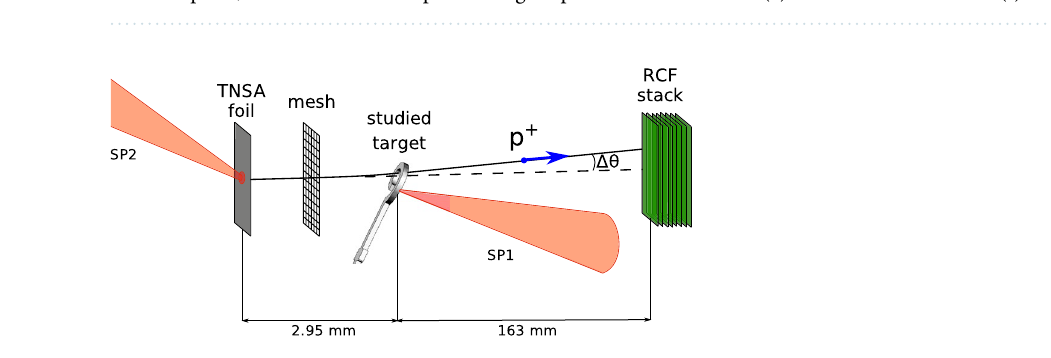
Figure 1. The target sketch ( a ) and the magnified photographic image ( b ). Scheme of the setup used in Shot #18 ( c ) and #22 ( d ). Proton radiography image obtained in Shot #18 in the second layer of RCF stack, corresponding to Bragg peak position for ≈ 3 MeV protons, passing the studied region ≈ 25 ps after the end of the laser pulse; darker colors correspond to higher proton concentrations ( e ). The same for Shot #22 ( f ).